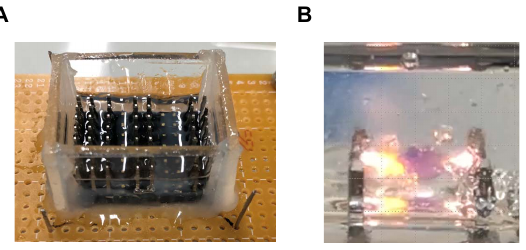
Figure 1. Experimental apparatus for an aqueous droplet actuation in dielectric oil [35]. ( A ) Overview of the apparatus. ( B ) Typical short-circuiting via an aqueous droplet by applying DC HV electric field. A 3.0 µ L aliquot of RPMI-1640 was added to the silicone oil and 3.0 kV of DC HV was applied to the electrode with 5.08 mm